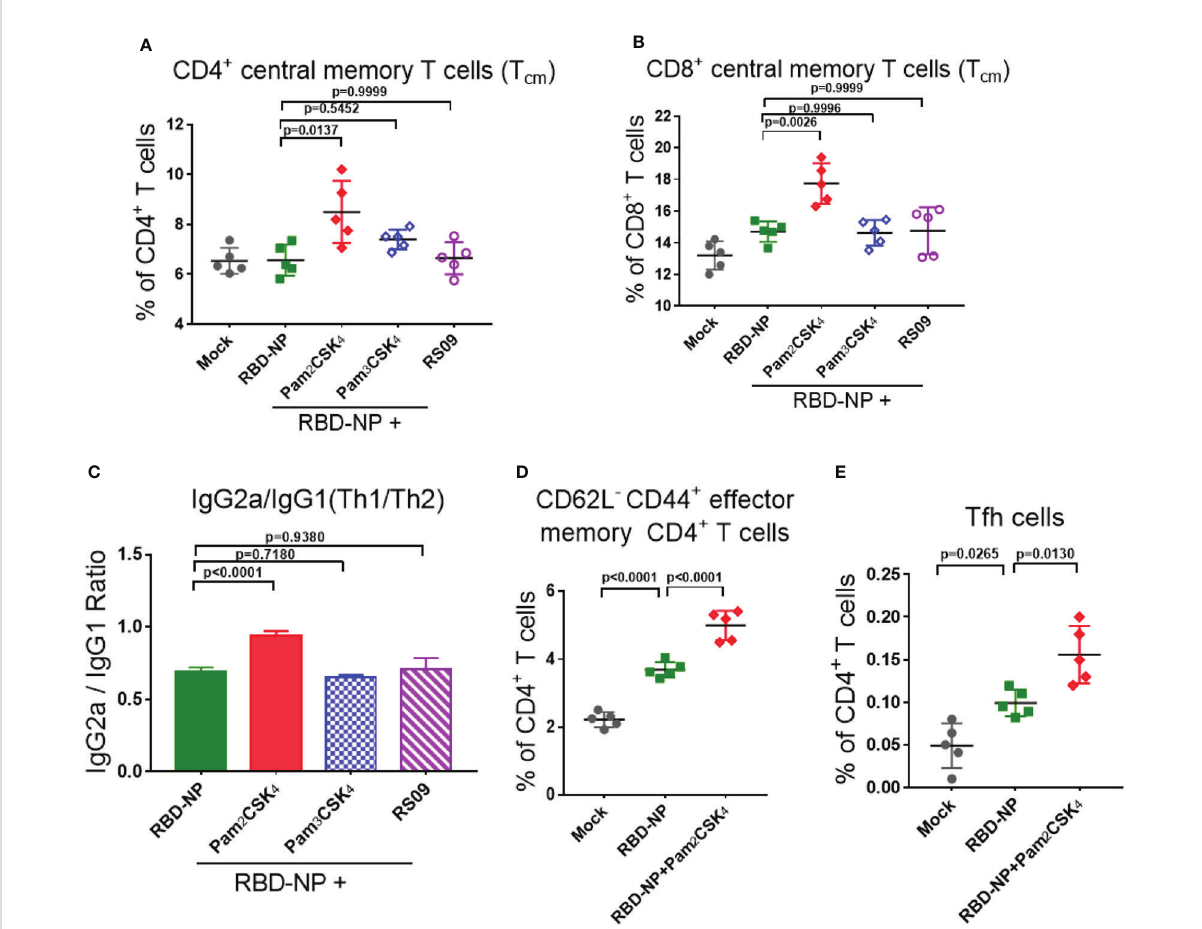
FIGURE 4 Evaluate the cellular immune responses of the adjuvanted SARS-CoV-2 nanoparticle vaccine in vivo . (A, B) Splenocytes were collected at week 10 and the central memory T cells were detected by fl ow cytometry. (A) CD4+CD62L+CD44+ Tcm cells; (B) CD8+CD62L+CD44+ Tcm cells (n=5). (C) IgG2a and IgG1 titers in sera were measured by ELISA at week 6, and the ratio of IgG2a/IgG1 represented a trend of Th1/Th2 response (n=5). (D) Mandibular lymph nodes were collected and the central memory CD4+ T cells (CD4+CD62L-CD44+ T cells) were analyzed 10 days after immunization (n=5). (E) Tfh cells (CD4+CXCR5+PD-1+) were collected from lymph nodes and analyzed 10 days after immunization (n=5). Experiments were performed at least three times independently. One-way ANOVA was used for Tukey ’ s multiple comparison test. Experimental data are expressed as Mean ±